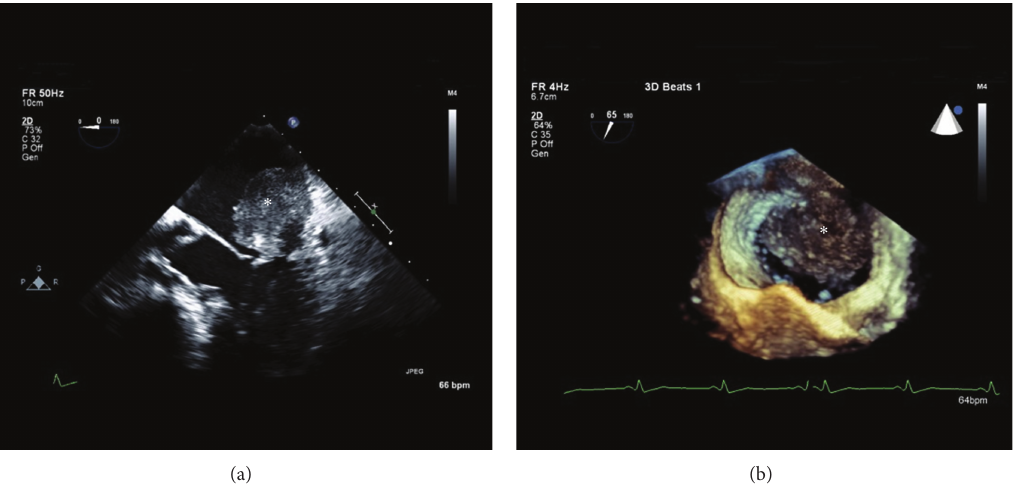
Figure 1: Two-dimensional (a) and magnified three-dimensional (b) transesophageal echocardiogram (TEE) of the left atrium (LA), mitral valve, and left ventricle. A 4.4 × 3.5 cm mass (asterisk) is seen attached to the posterolateral aspect of the